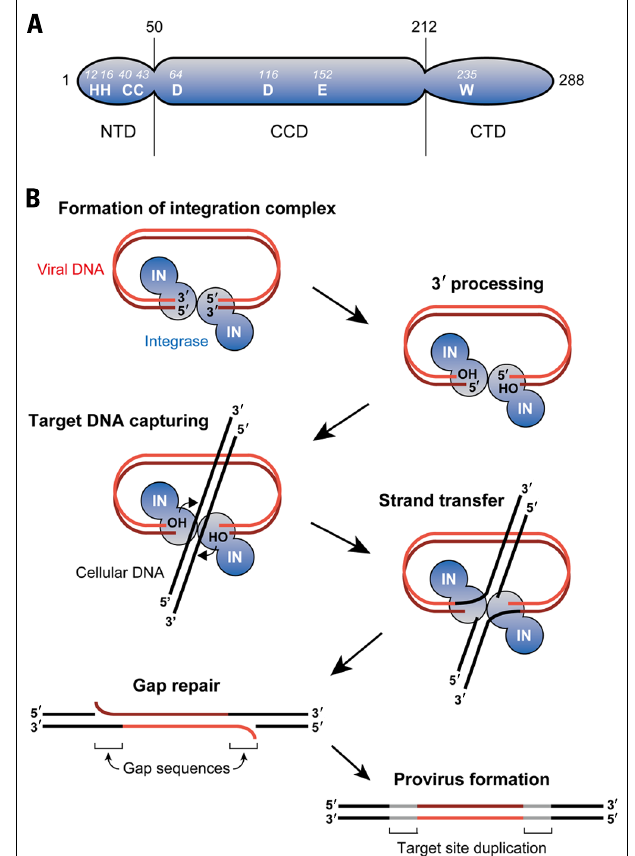
FIGURE 1 | Retroviral DNA integration. (A) As an example of retroviral INs, domain organization of HIV-1 IN is illustrated. IN is composed of three domains: N-terminal domain (NTD), catalytic core domain (CCD), and C-terminal domain (CTD). A triad of aspartic (D) and glutamic acid (E) residues termed the DDE motif is found in the CCD, which is highly conserved amongst retroviral INs. Binding of divalent ions such as Mg 2 + to the DDE motif domain plays a key role in integration reaction.The NTD contains a well-conserved motif comprising of two histidine (H) and two cysteine (C) residues (HHCC motif) that coordinates Zn 2 + binding. In contrast to the NTD and CCD, the CTD is the least conserved domain, although tryptophan (W) is conserved among the retroviral INs.This domain exhibits non-specific DNA-binding activity in vitro . (B) Retroviral integration is initiated by IN’s recognition of both ends of viral DNA and subsequent removal of two (or three) nucleotides from each of the 3 (cid:2) ends (3 (cid:2) processing).The target DNA (i.e., chromosomal DNA) captured by IN is cleaved in a staggered fashion via the exposed hydroxy (OH) groups on the viral DNA ends, and the 3 (cid:2) end of the viral DNA and the 5 (cid:2) end of the target DNA is simultaneously linked (strand transfer).The 3 (cid:2) processing and strand transfer steps are reproducible in vitro using recombinant IN, indicating that IN alone suffices to catalyze these steps. However, in infected cells, excision of the mispaired 5 (cid:2) viral DNA ends and filling in the single-strand gaps are carried out by yet-to-be identified cellular